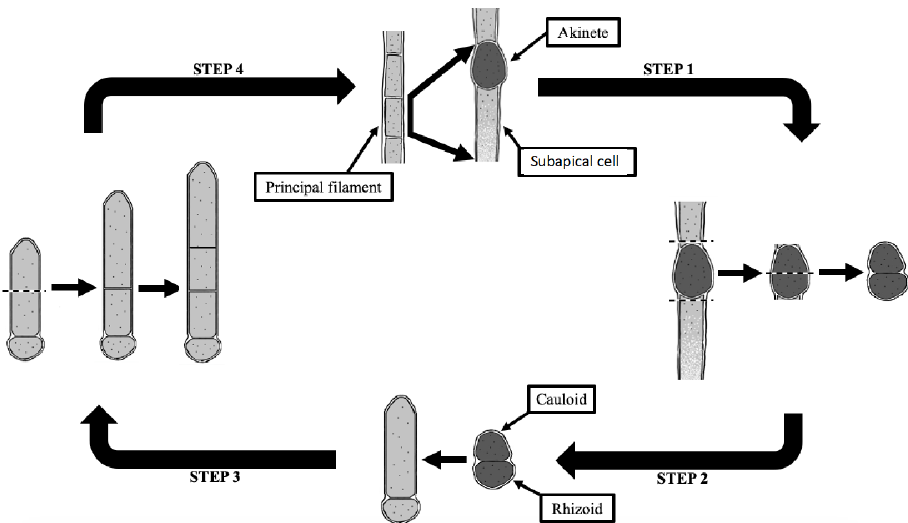
Figure 7. Schematic of the asexual reproduction of Pithophora . (Step 1) The formation of an akinete from a vegetative cell enclosed within the principle filament. (Step 2) The formation of a cauloid and rhizodal cell from the division of the akinete. (Step 3) The elongation of the cauloid cell. (Step 4) The formation of a new thallus, as in Step 1, from the further division and elongation of the uppermost cauloid cells.